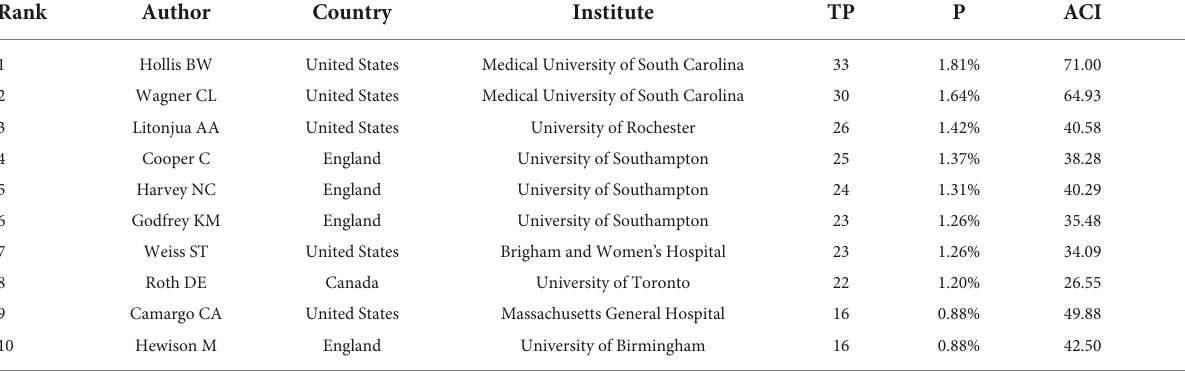
TABLE 5 Top 10 authors in the studies of vitamin D and reproductive